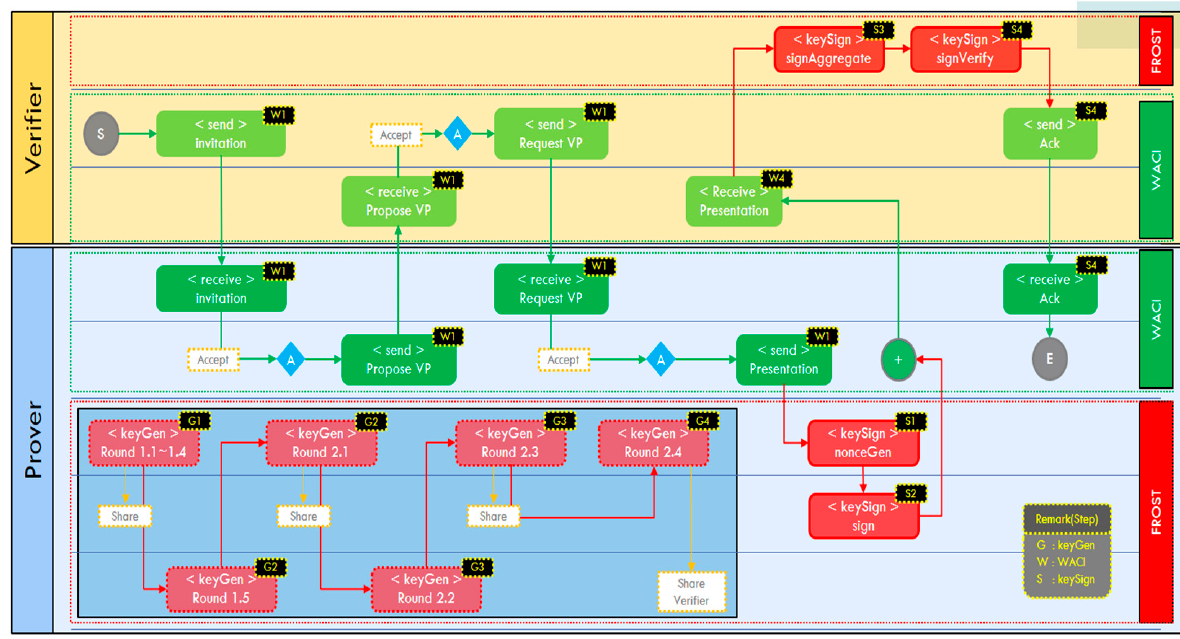
Figure 6. Functional fl ow chart of the proposed method